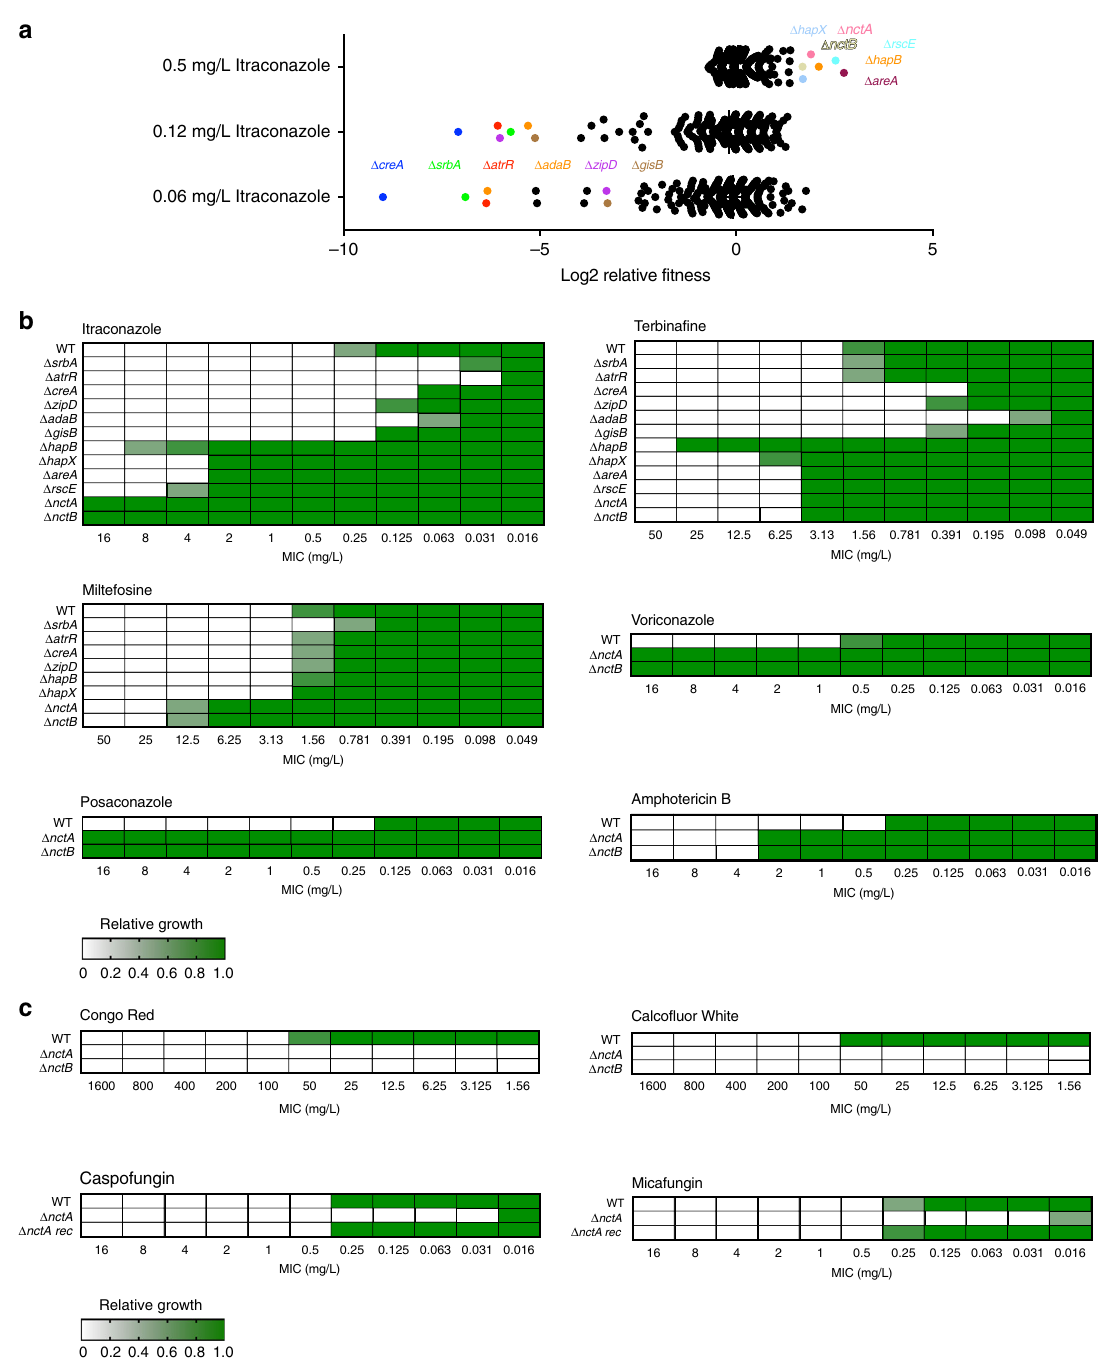
Fig. 1 Identi fi cation of transcription factors associated with azole tolerance in A. fumigatus . a Relative growth fi tness of the 484 constructed TFKO mutants in MIC (0.5 mg/L) and sub-MIC (0.06 and 0.12 mg/L) levels of itraconazole. Each dot represents the mean of three replicate experiments. The TFKOs which exhibited signi fi cant fi tness defects ( fi tness less than − 4 for sub-MIC, and more than 1.5 for MIC condition) are indicated by coloured circles. b , c Heatmaps showing drug susceptibility pro fi les of the screened TFKO mutants to different antifungal drugs. Susceptibility assays were performed in triplicate, where optical density readings of fungal growth were standardised to no-drug control wells and shown as a relative growth values. Source data are provided as a Source Data fi